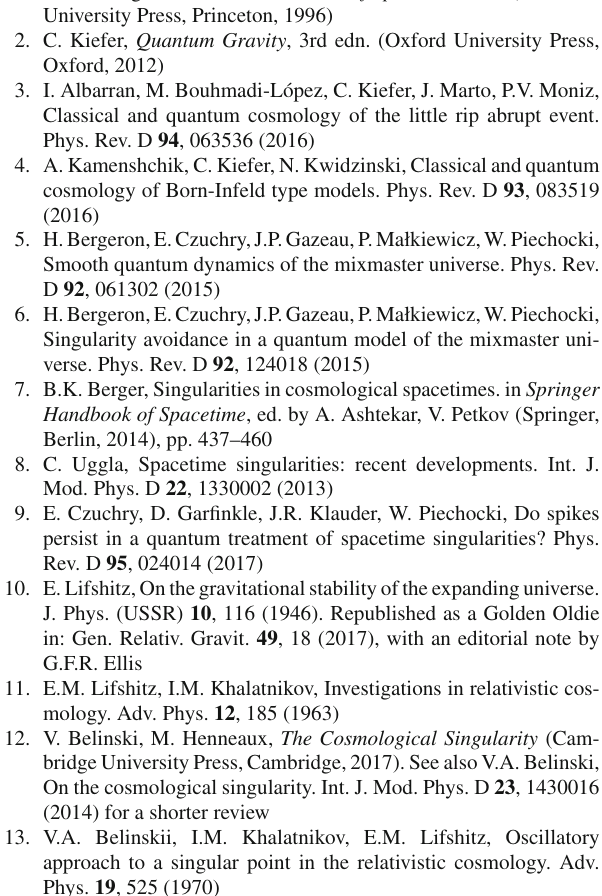
Fig. 5 a Shows the error in the Hamiltonian constraint. b Shows the speed of the universe point in the beta plane as measured in “ α -time”. This plot can be viewed as another check of the numerics. Between two successive bounces from the potential walls this quantity should be close to one. If this ceased to be true it would indicate that the error in